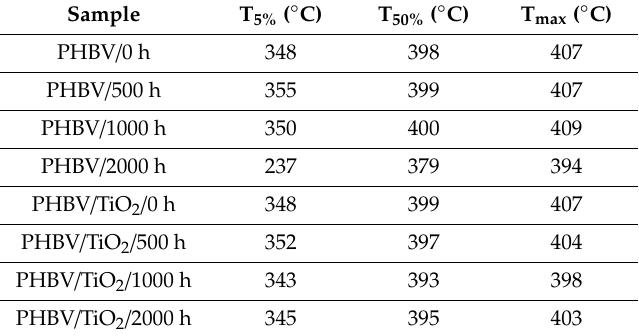
Table 3. Characteristic degradation temperatures for the PHBV and the PHBV / TiO 2 samples obtained from the TGA and derivative TGA (dTGA) curves (not